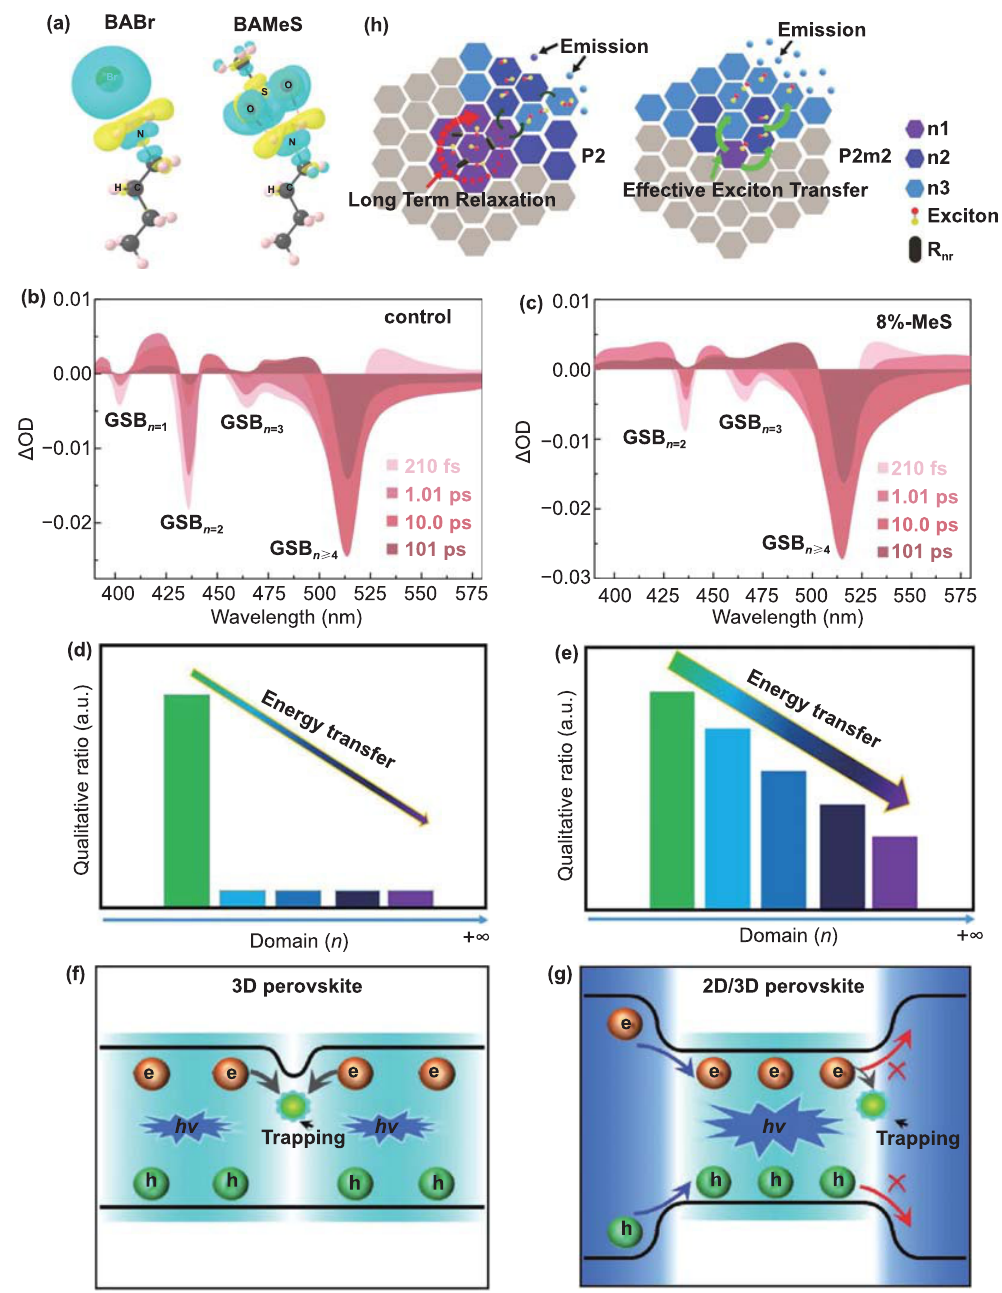
Fig. 12 a Hydrogen bond calculations. Differential charge density diagrams of BABr and BAMeS (where isosurface value is 0.0015 eV Å −3 ; cyan is charge accumulation; yellow is charge depletion). TA spectra at selected timescales of the b control and c 8%-MES perovskite films. Copyright 2021 Springer Nature [134]. The energy transfer process of d BAB33 and e BAB25 perovskite films was studied. Copyright 2019 American Association for the Advancement of Science [79]. Comparison of f 3D and g 2D/3D perovskite film carrier recombination. Copyright 2020 Wiley–VCH Verlag [163]. h Domain distribution, exciton transfer and emission properties of P2 and P2m2 films. Copyright 2019